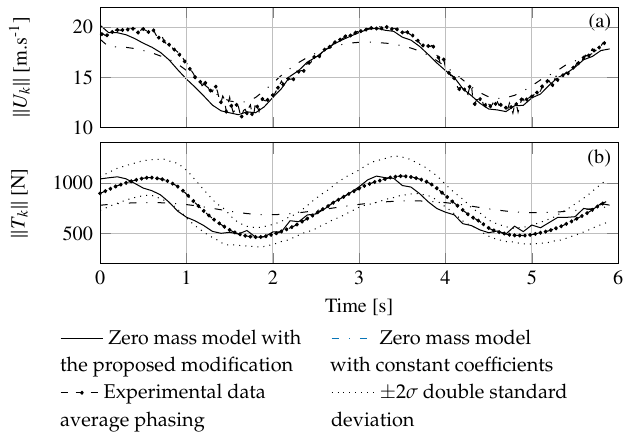
Figure 9. Evolution of the kite velocity ( a ) and of the tether tension at A , along the average trajectory ( b ); comparison between the zero mass model with constant aerodynamics and the model with a linear modification of the kite aerodynamic characteristics using phase averaging of experimental data from Behrel et al.